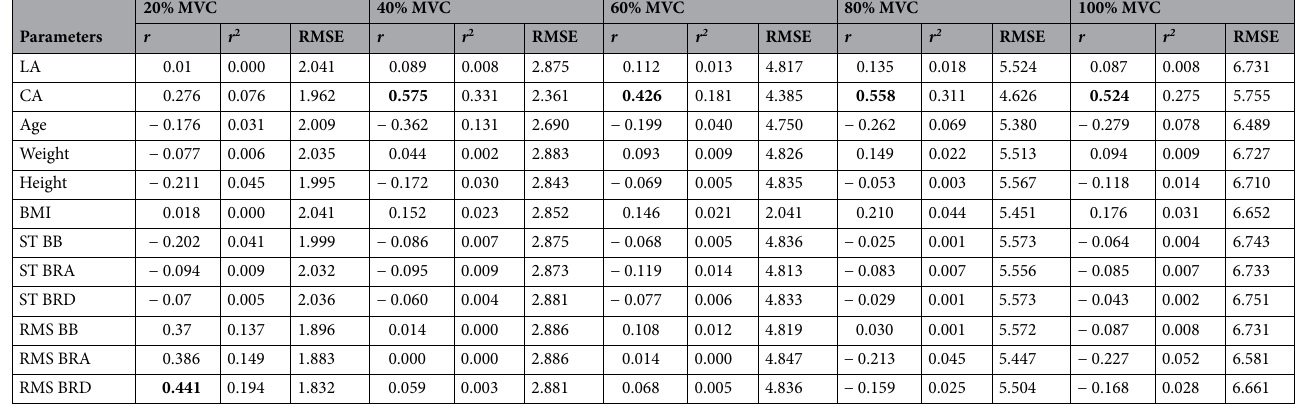
Table 2. Bivariate analysis of torque against anthropometrics and MMG RMS during flexion task. *Bold font indicates significant